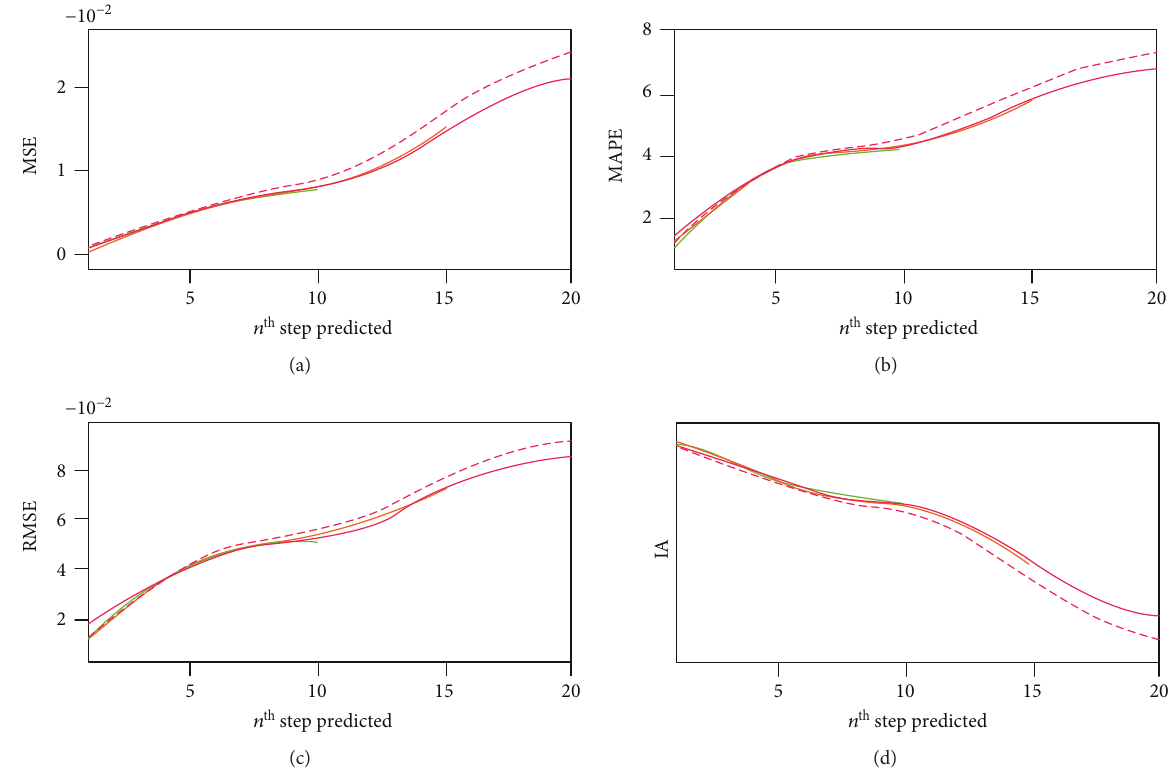
Figure 10: Great Salt Lake system: indicators from ANN (solid) and from LS-SVM (dashed) — (a) MSE, (b) MAPE, (c) RMS, and (d)